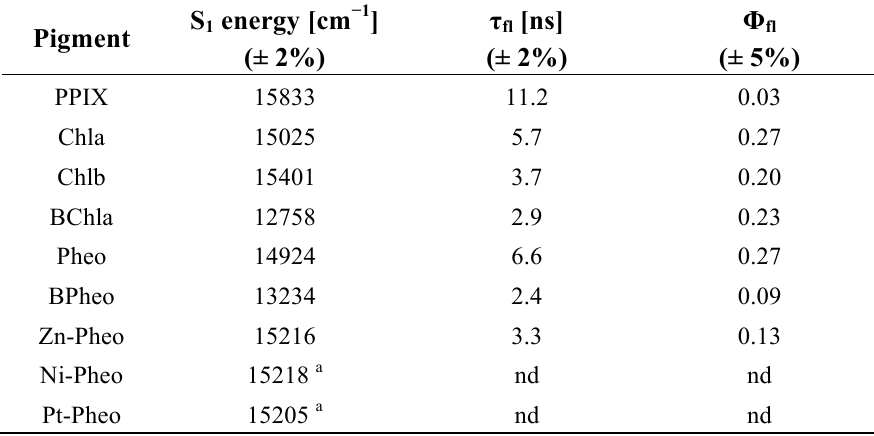
Table 1. Selected ground- and excited-state properties of model pigments estimated in acetone at ambient